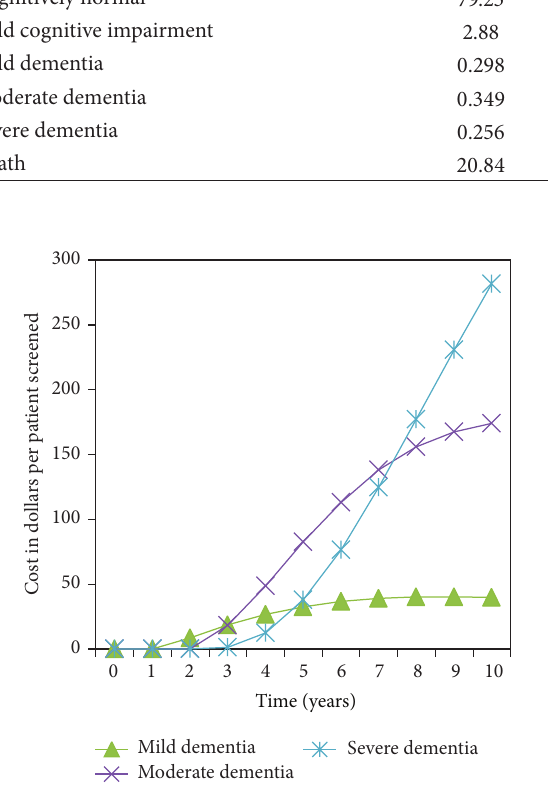
Figure 1: Dementia care costs versus time without dementia screening.